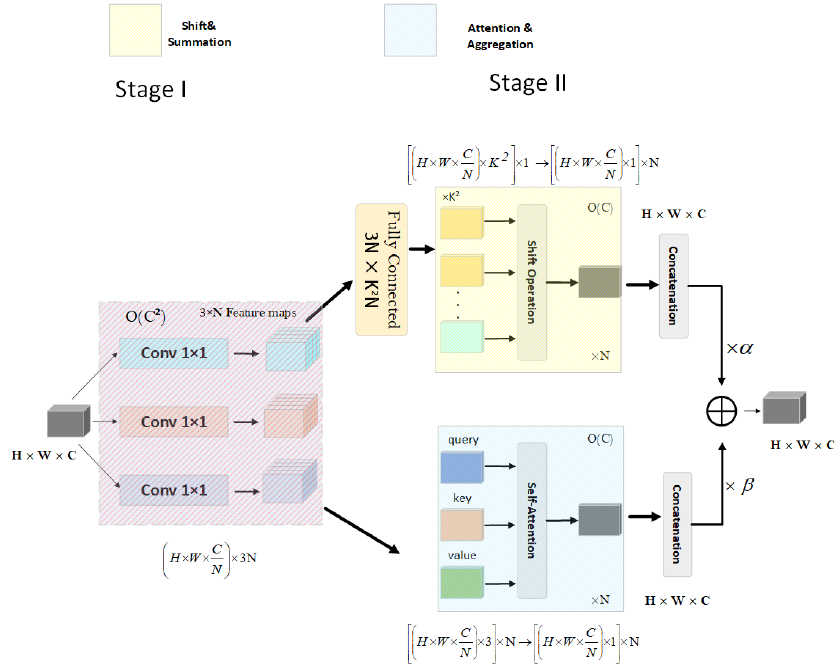
Figure 4. ACmix attention mechanism algorithm model.